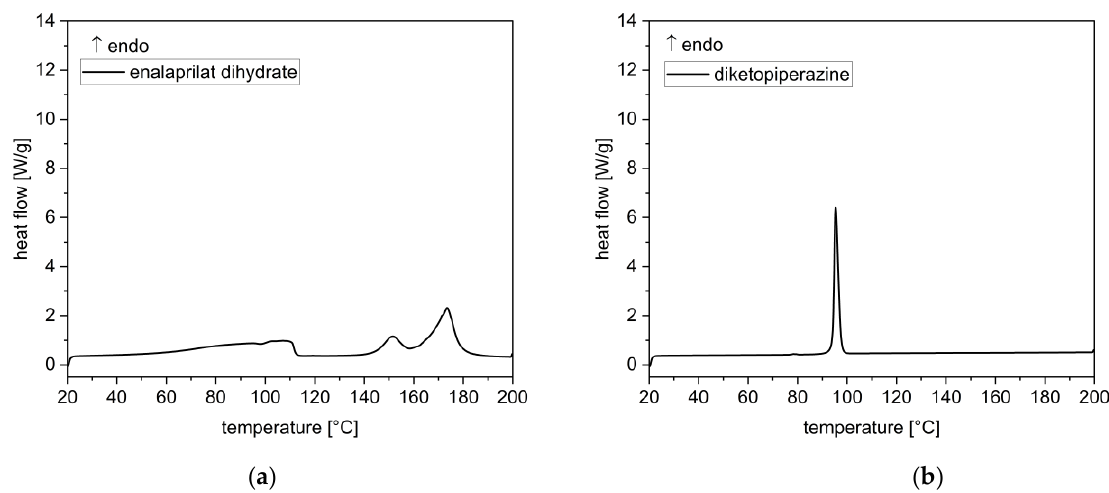
Figure 5. DSC thermograms of the main degradation products enalaprilat as dihydrate ( a ) and enalapril diketopiperazine derivative ( b ).